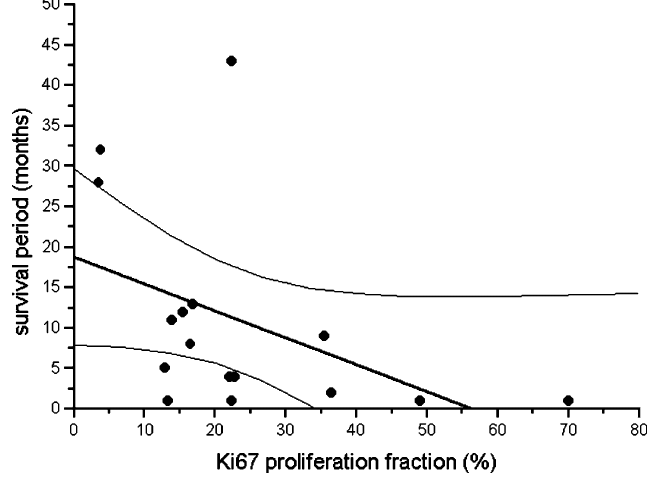
Fig. 2. Ki67 proliferation fraction (%) plotted against survival period of patients with malignant mesotheliomas, regression line and 95% confi- dence